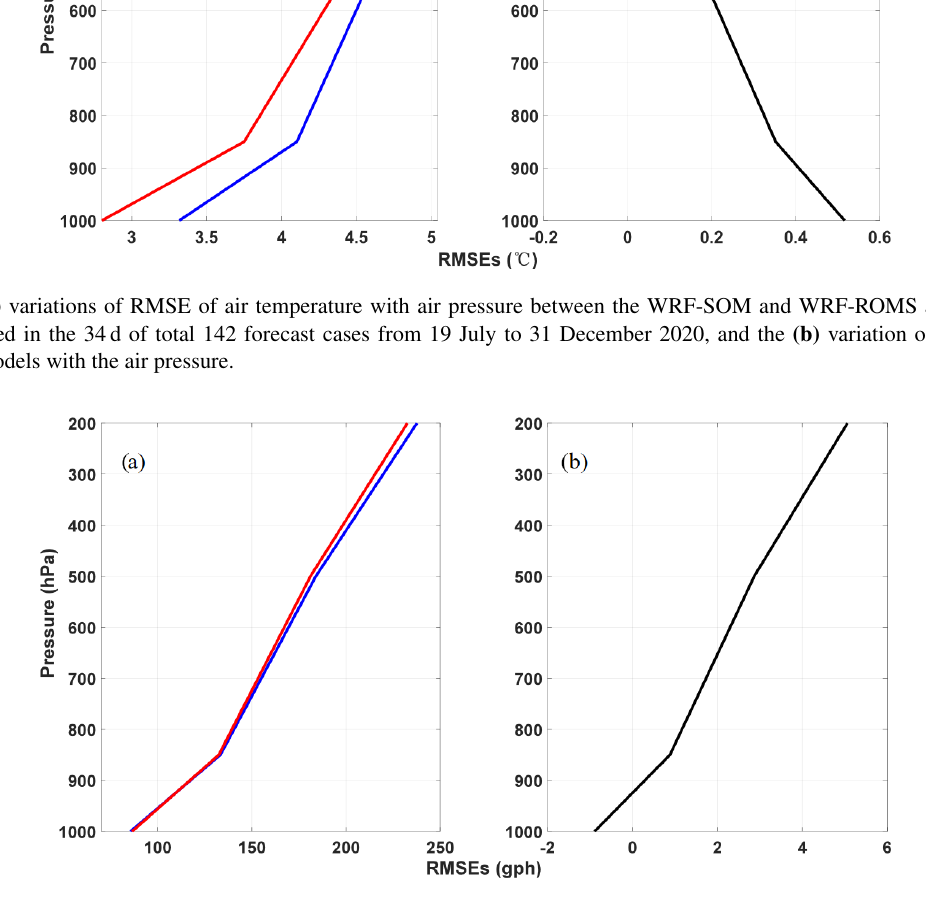
Figure 8. The (a) variations of RMSEs of the geopotential height (GPH) with air pressure in the WRF-SOM (red) and WRF-ROMS (blue) against CFSv2 reanalysis of total 142 forecast cases from 19 July to 31 December 2020, and the (b) variation of the difference of RMSEs in two models with the air